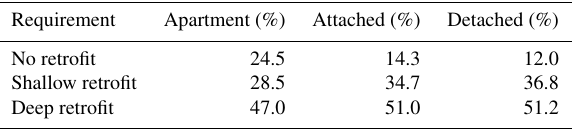
Table 13. Process